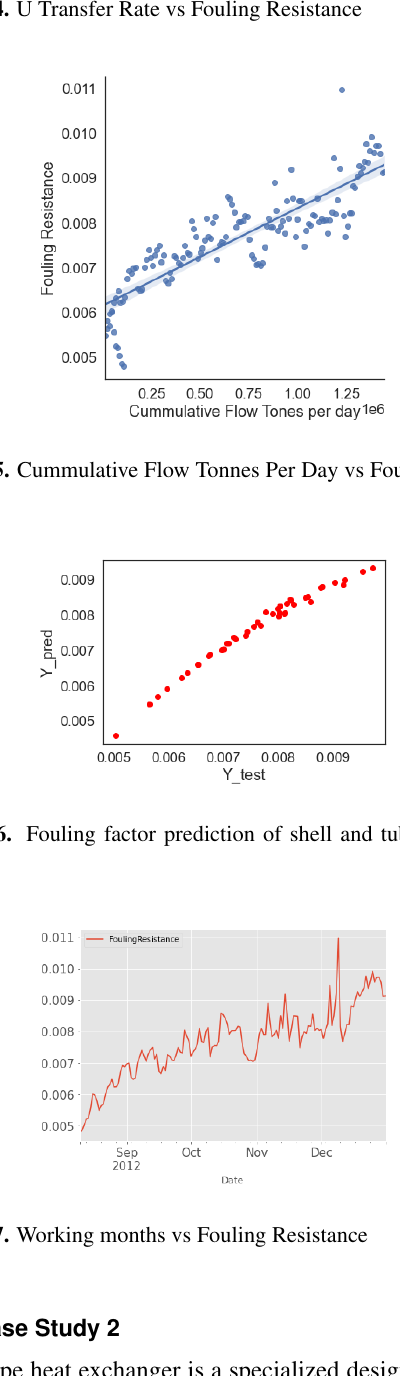
Figure 4. U Transfer Rate vs Fouling Resistance